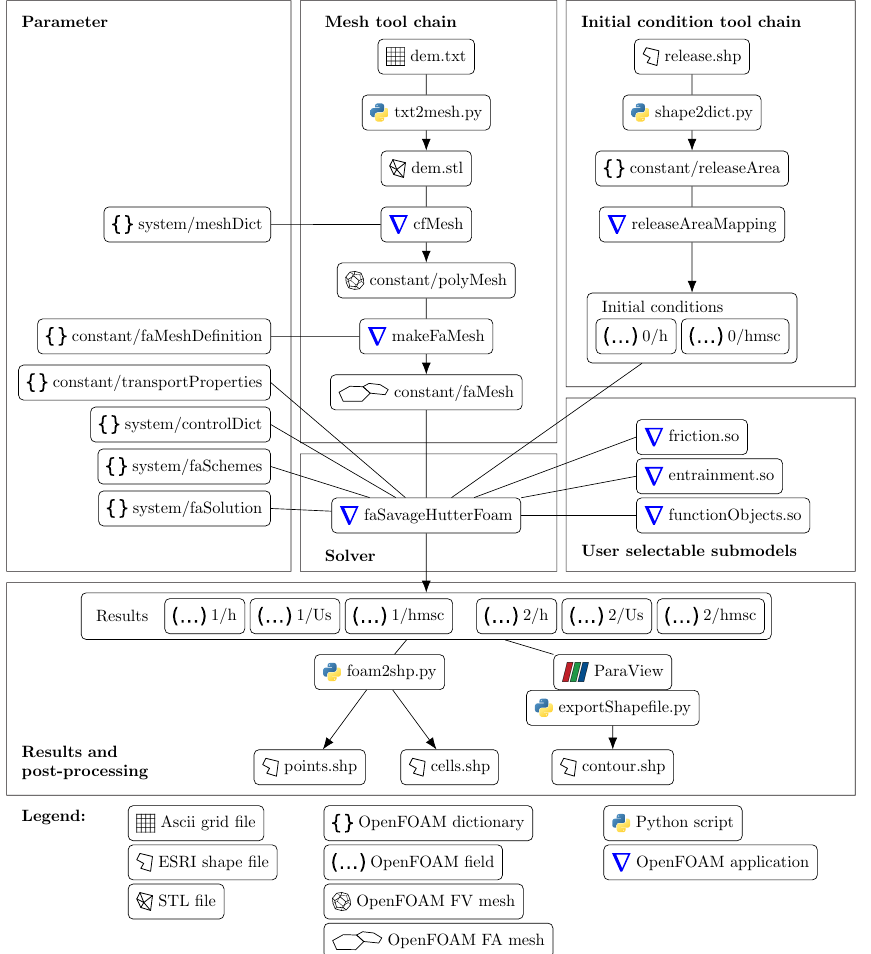
Figure 2. Simulation set-up and tool chain. The tool chain consists exclusively of open-source applications. Individual applications and process models can be replaced with custom ones. Parameters for python scripts are provided via a command line interface. Parameters for OpenFOAM applications are provided through OpenFOAM dictionaries. Domain decomposition and reconstruction, which is handled by separate applications, is not shown. OpenFOAM reads initial conditions from the folder “0” and writes results to folders named after the corresponding time step (“1”, “2”, etc.). Details on OpenFOAM formats can be found in OpenCFD Ltd.